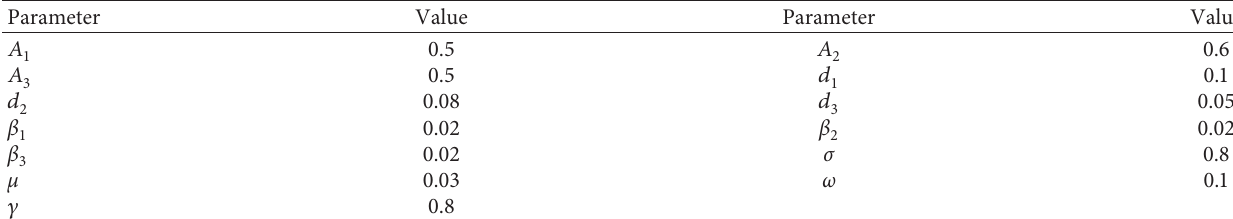
Table 4: List of